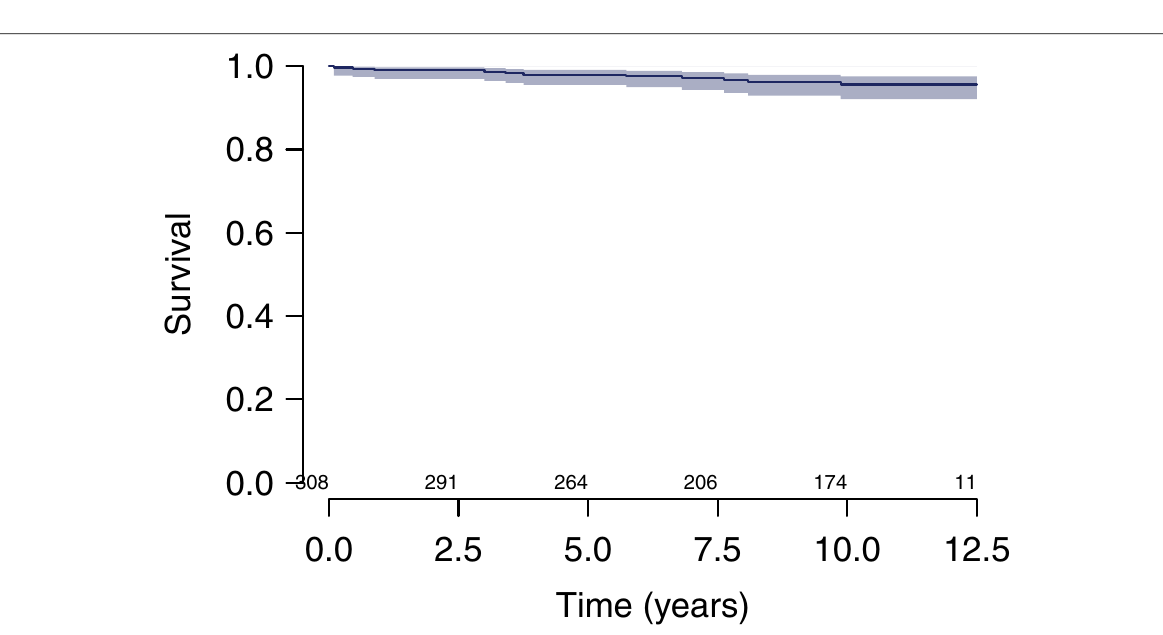
Fig. 5 Survival at 10 years estimated using the KM method was 95.6% (CI, 92.1–97.6%) considering any revision for any reason as